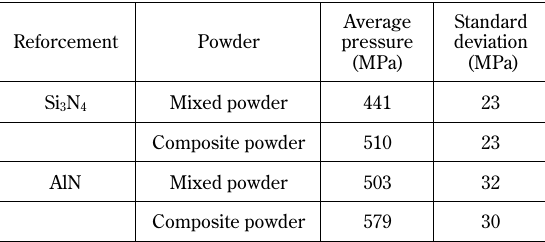
Table 4 Pressures necessary to extrude the mixed and the com- posite